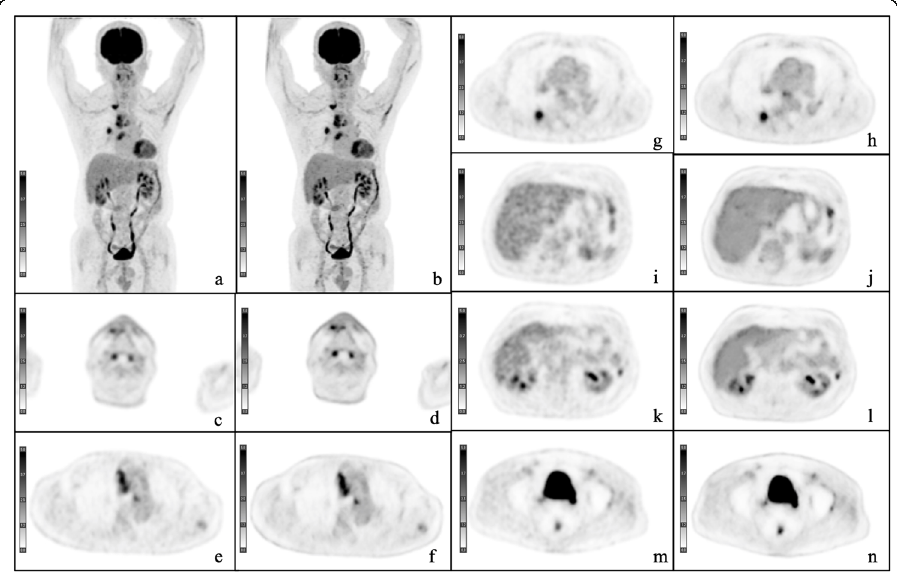
Fig. 4 A representative case. A 67-year-old male patient with metastasized non-small cell lung carcinoma. Maximum intensity projection and axial positron emission tomography images with conventional Gaussian filter a , c , e , g , i , k , m and those obtained with a deep learning method b , d , f , h , j , l ,